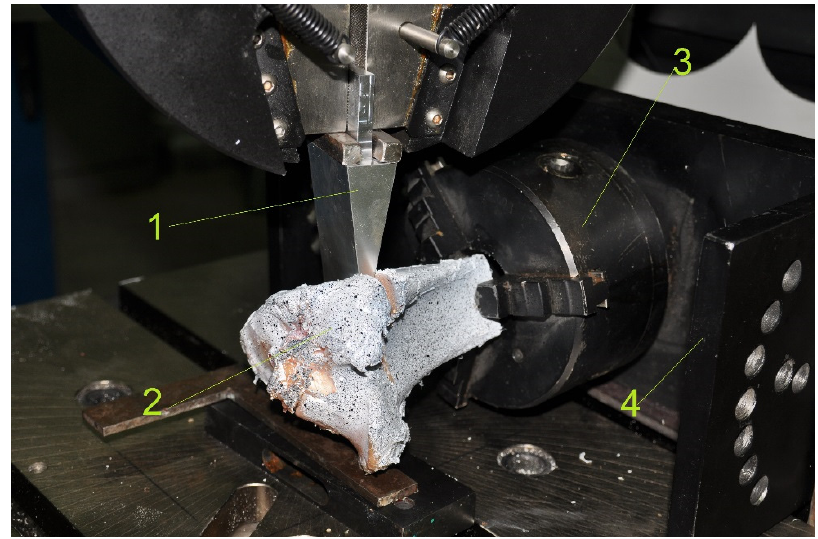
Figure 7. Experimental conduct of medial opening wedge HTO.